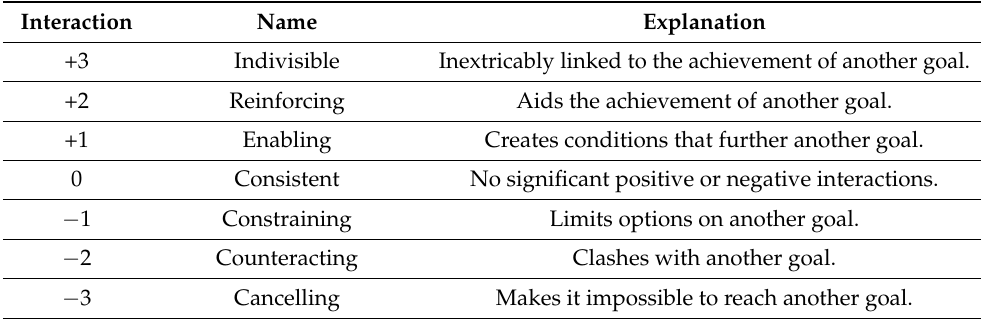
Table 2. Scoring scale for measuring the interaction between the SDGs and their targets (UN-Water, 2016). Interaction Name Explanation